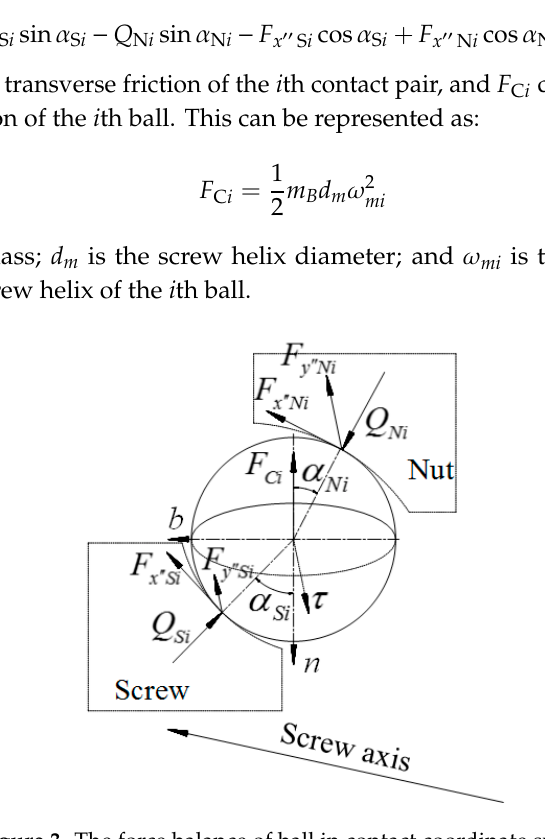
Figure 3. The force balance of ball in contact coordinate system.